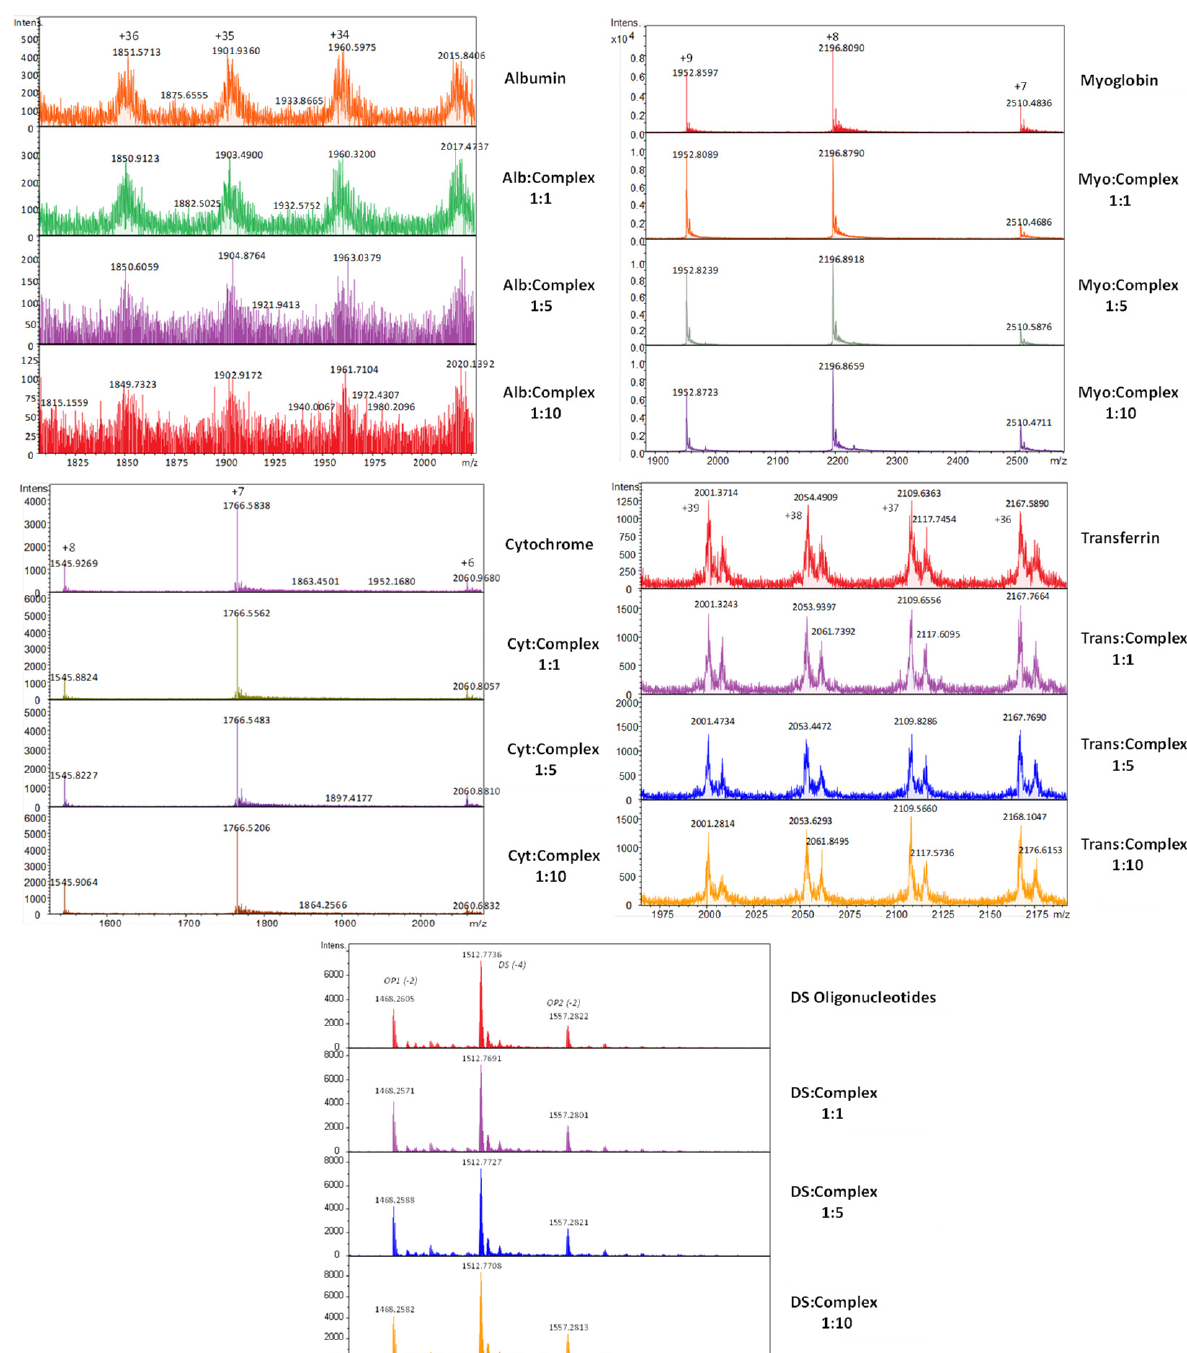
Figure 7. ESI MS-TOF obtained during the titration of albumin, myoglobin, cytochrome C and transferrin proteins, and double-stranded oligonucleotides (DS) stock solutions with helicate 1 .